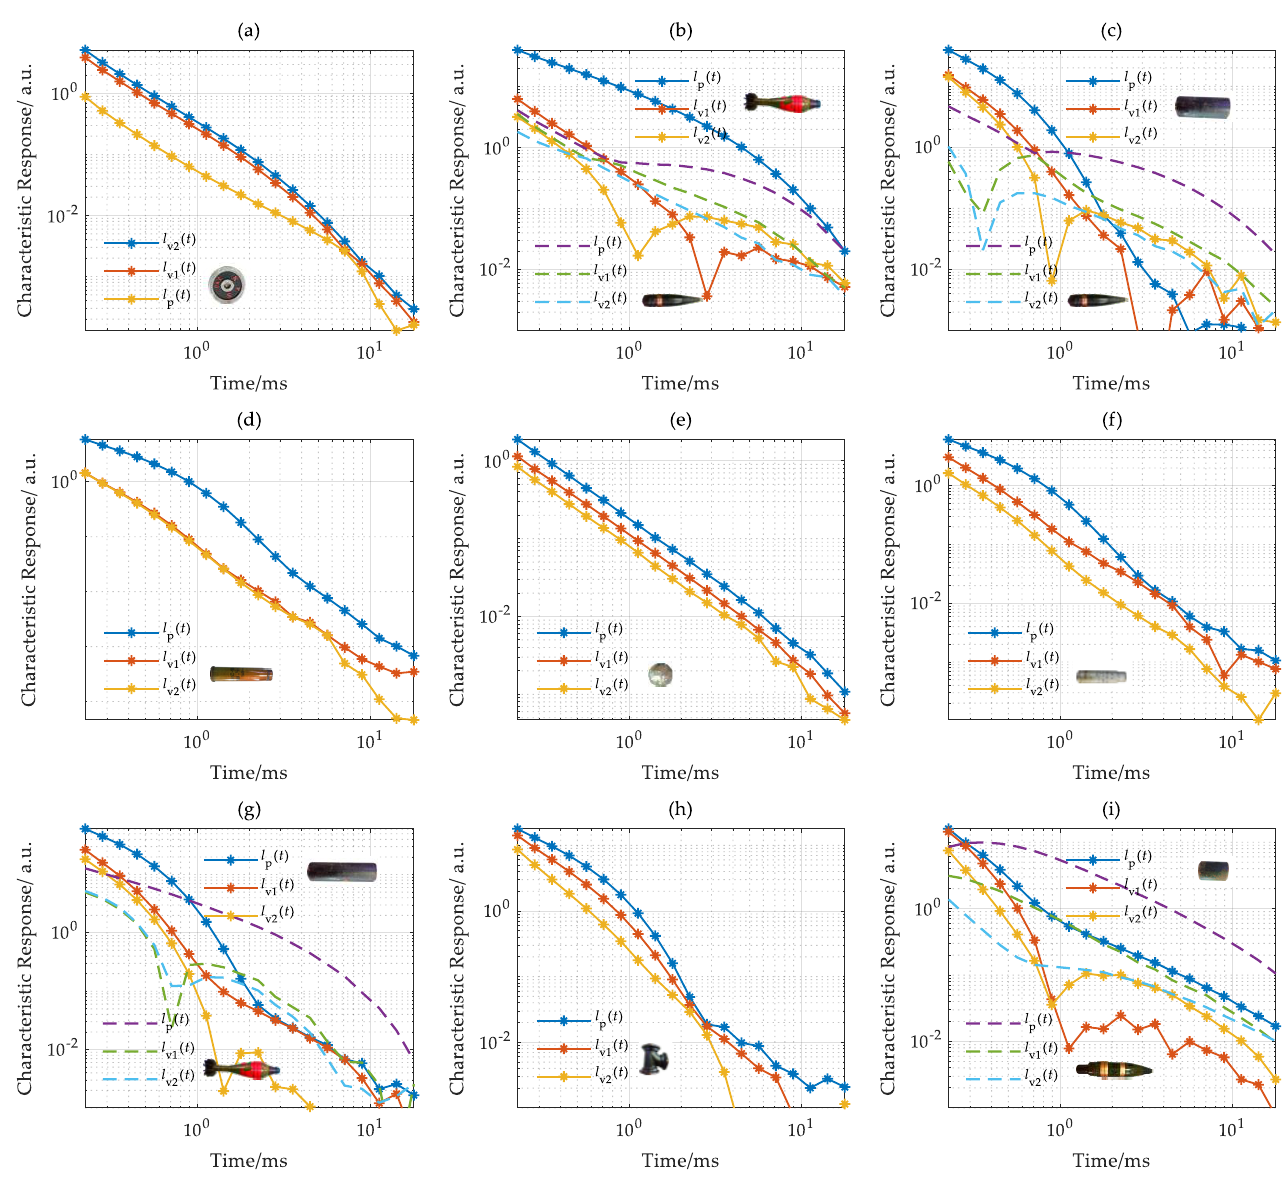
Figure 14. Characteristic response in the survey line with y = 1.0 m. ( a ) O7, ( b ) U3 and U1, ( c ) O5 and U5, ( d ) O2, ( e ) O8, ( f ) O1, ( g ) O6 and U3, ( h ) O9, ( i ) O4 and U2.